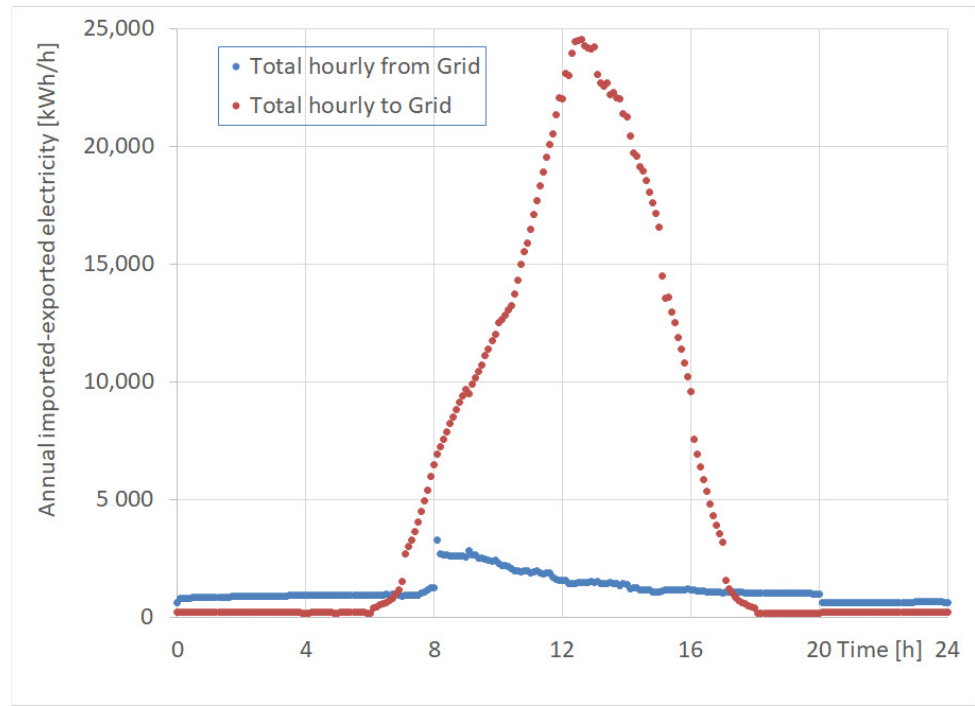
Figure 17. Total annual electricity that is imported—exported to the grid during the different hours of the day.